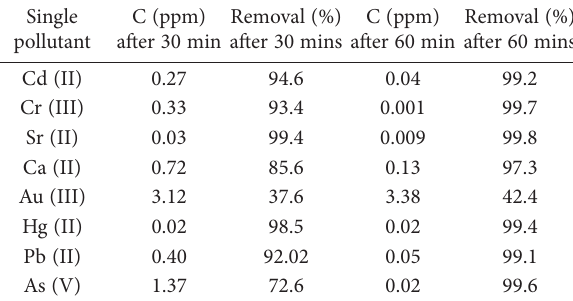
Table 3. Ion fl otation results of diff erent single heavy metals in aqueous solution using S-octanoyl-cys (C(surfactant, initial) = 0.01M, C(heavy metal ion, initial) = 5 mg/L (ppm), and pH = 8). (Reproduced from 12, 20 ).